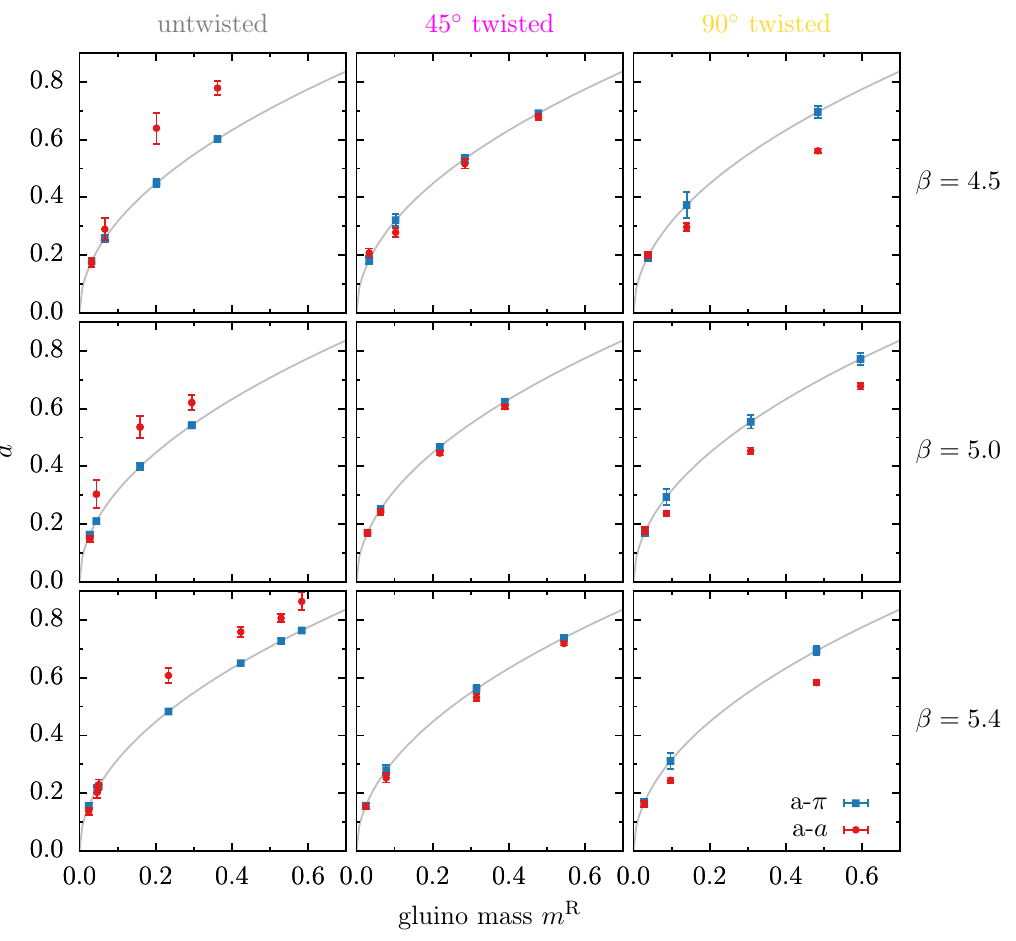
Figure 8 . Connected mesons on the 16 3 × 32 lattice. From left to right the twist angle α ∈ { 0 ◦ , 45 ◦ , 90 ◦ } rises. From top to bottom the lattice coupling β ∈ { 4 , 5 . 5 . 0 , 5 . 4 } increases. Some error bars are smaller than the symbol size and some data points for α = 45 ◦ lie on top of each other. The gray solid lines visualize eq.